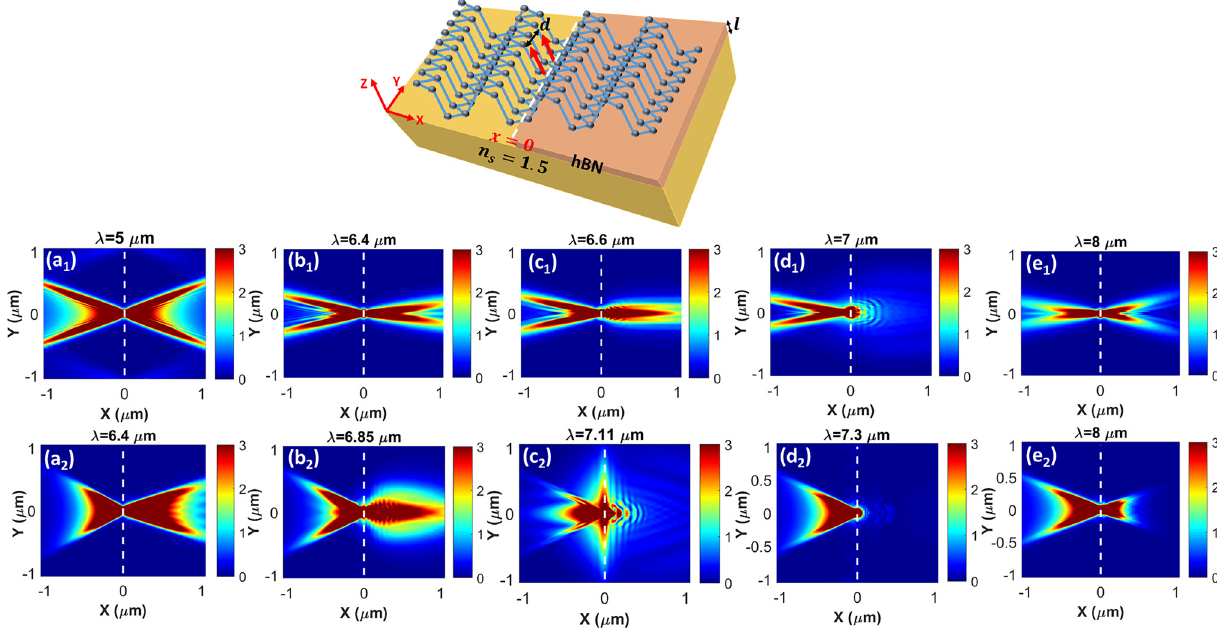
Figure 5: (top) Double heterostructure composed of A2DM/sub structure for x < 0, A2DM/hBN/sub structure with l (cid:1) 20 nm for x > 0, and a uniform A2DM sheet on top of them, and (bottom) density plots of electric fi eld | E | at different wavelengths for [(a 1 ) – (e 1 )] n (cid:1) 10 14 cm − 2 and [(a 2 ) – (e 2 )] n (cid:1) 3 × 10 13 cm − 2 . A pair of z -oriented electric dipoles (red arrows) are 30 nm apart and 10 nm above the A2DM sheet. Vertical dashed lines show the boundary between the A2DM/sub and A2DM/hBN/sub